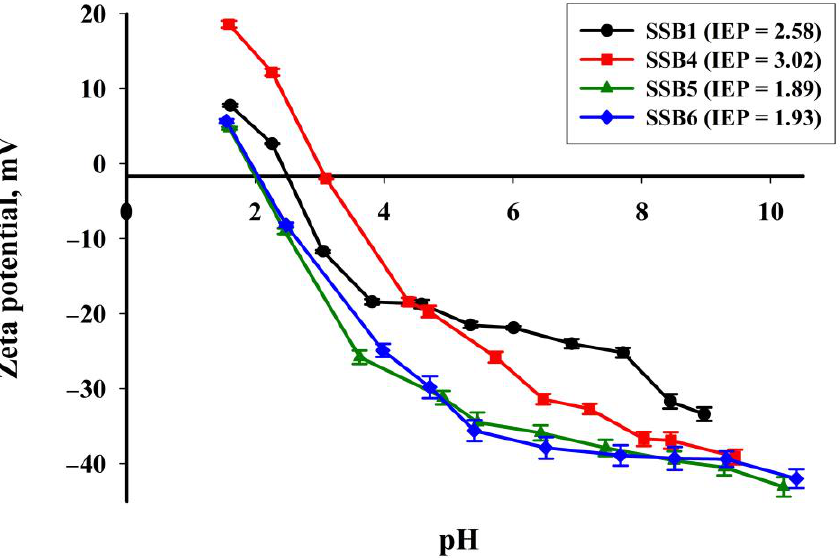
Figure 11. Zeta potential vs. pH for the obtained selected biochars.